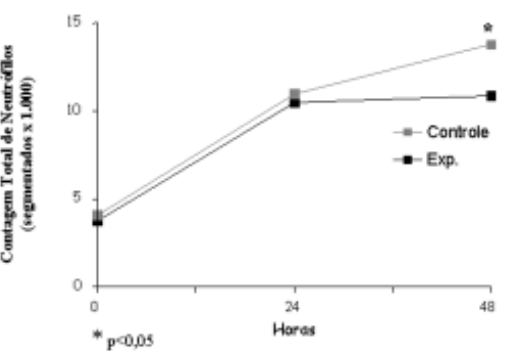
Fig. 1 - Contagem de neutrófilos